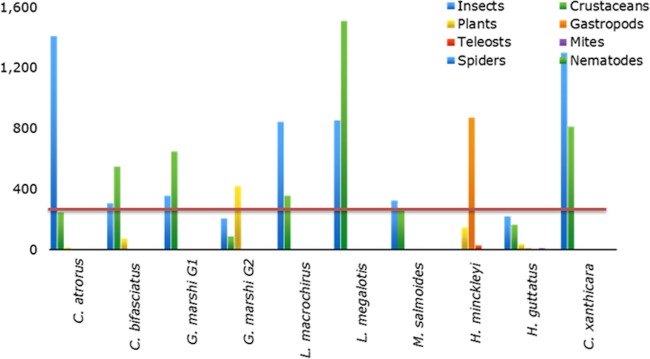
Coefficient of fish feed that delimits the categories of preferential foods in: primary, secondary and rare.